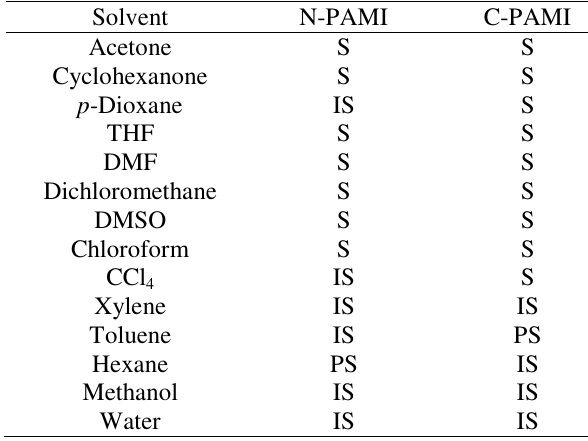
non-polar solvents at 30°C.